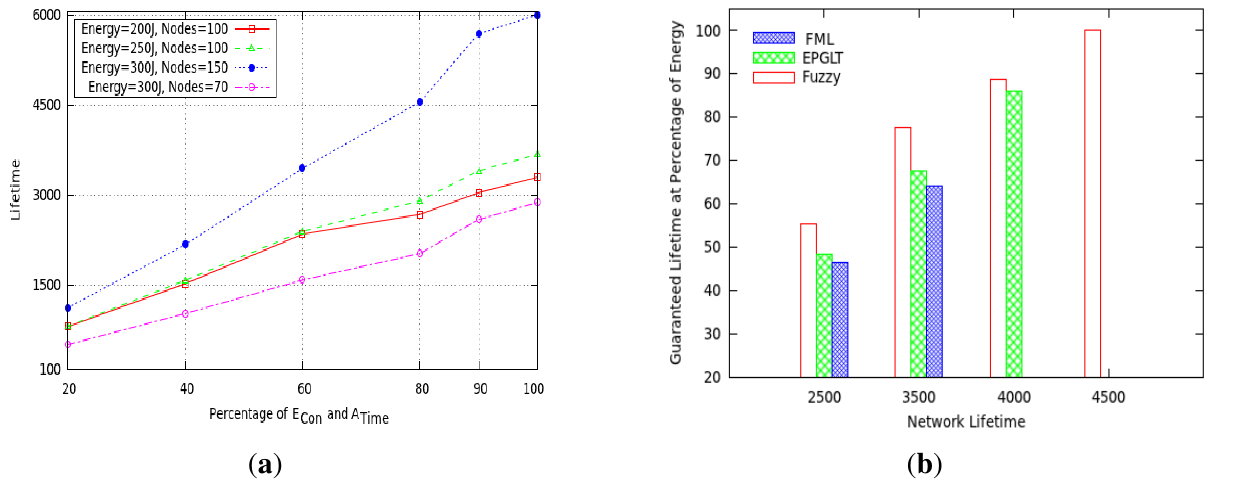
Figure 5. Various values of α to guarantee. ( a ) Network lifetime; ( b ) guaranteed lifetime at the % of